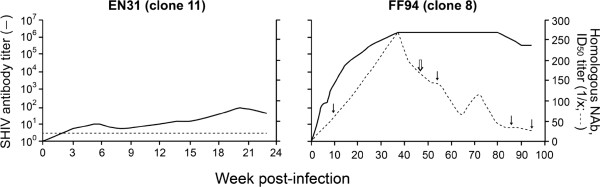
SHIV-specific antibody response. SHIV binding and homologous neutralizing antibody titers in EN31 (clone 11) and FF94 (clone 8) are shown. Closed arrows indicate time points when Ing LN biopsies were collected and analysed, with open arrow indicating time of X4 detection.